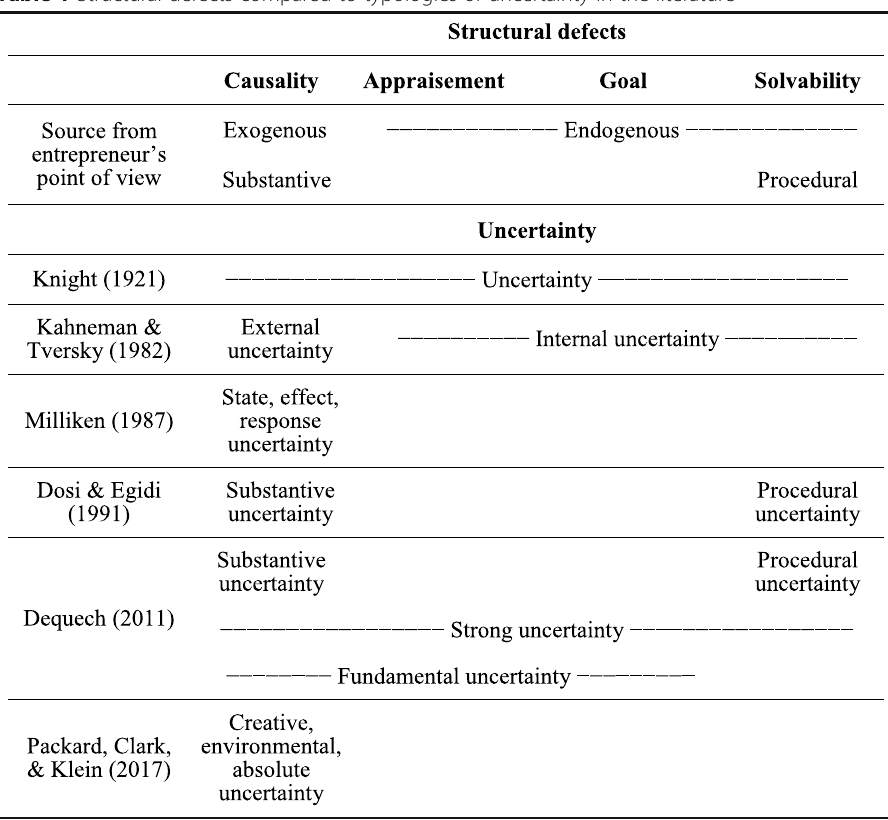
Table 1 Structural defects compared to typologies of uncertainty in the